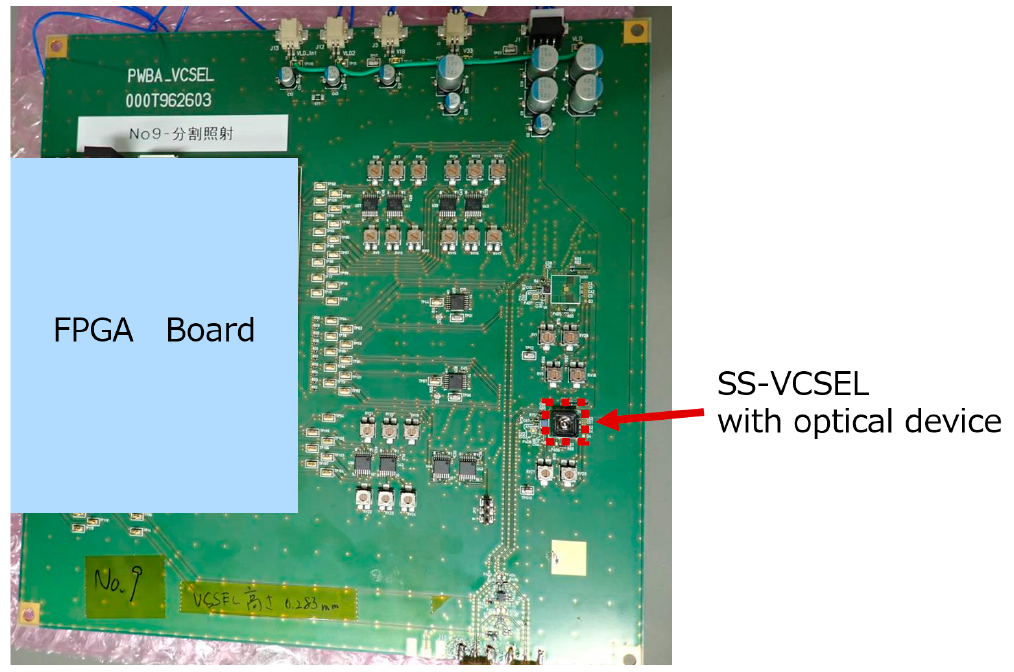
Figure 5. Top view of Tx module containing the SS-VCSEL and the optical device.